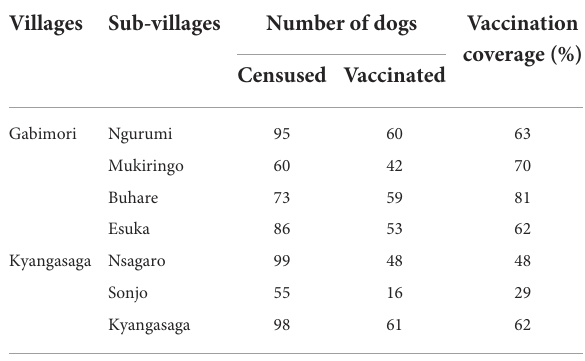
TABLE 5 Number of dogs censused and vaccinated in Kyangasaga Ward during the demonstration vaccination